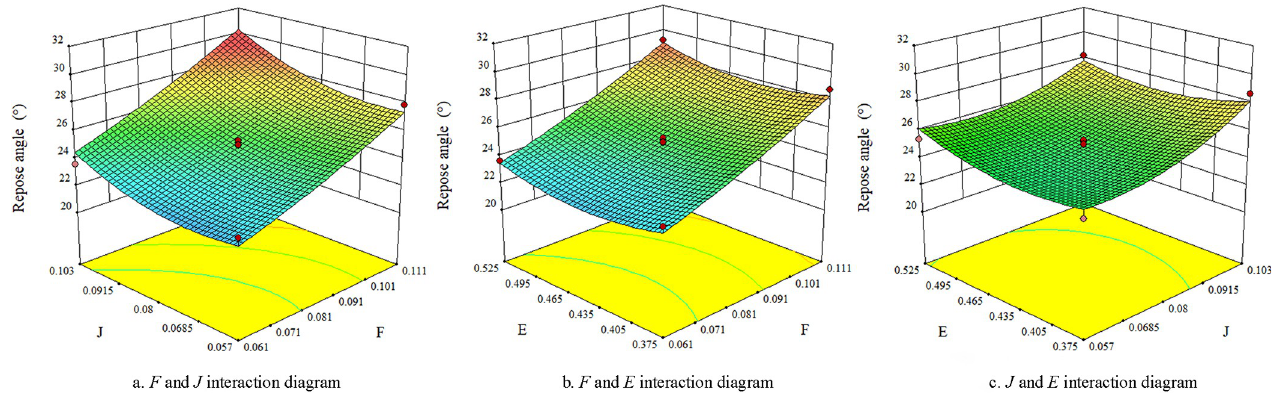
Fig 6. Effect of interaction on repose